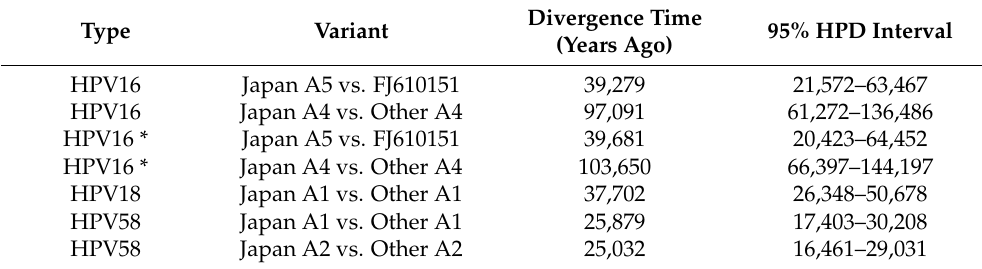
Table 1. Divergence time estimates of MRCAs of the Japan-specific HPV variants.